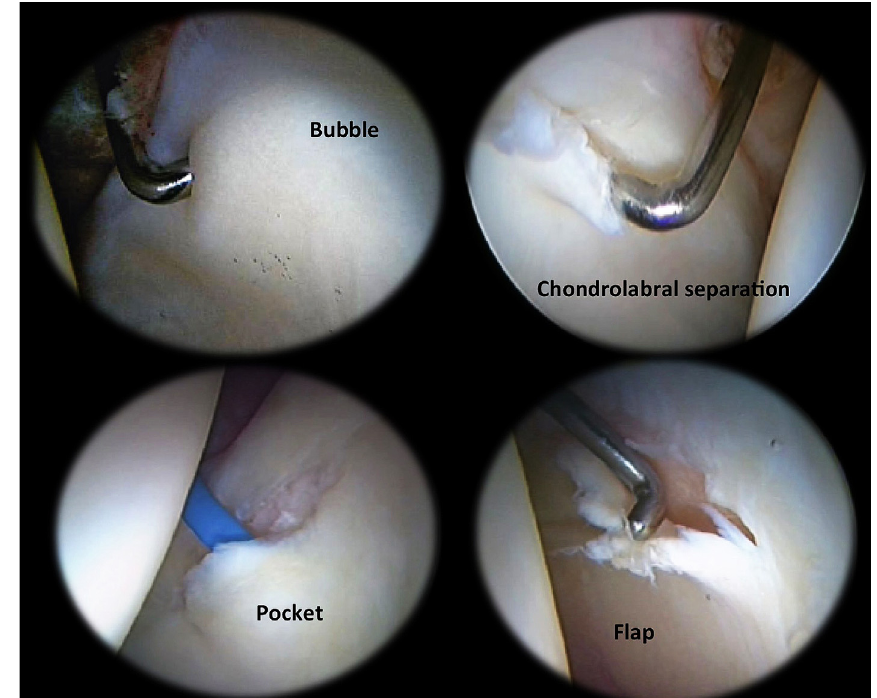
Figure 3. MAHORN classification. Bubble (upper left), separation (upper right), pocket (bottom left), flap (bottom right).